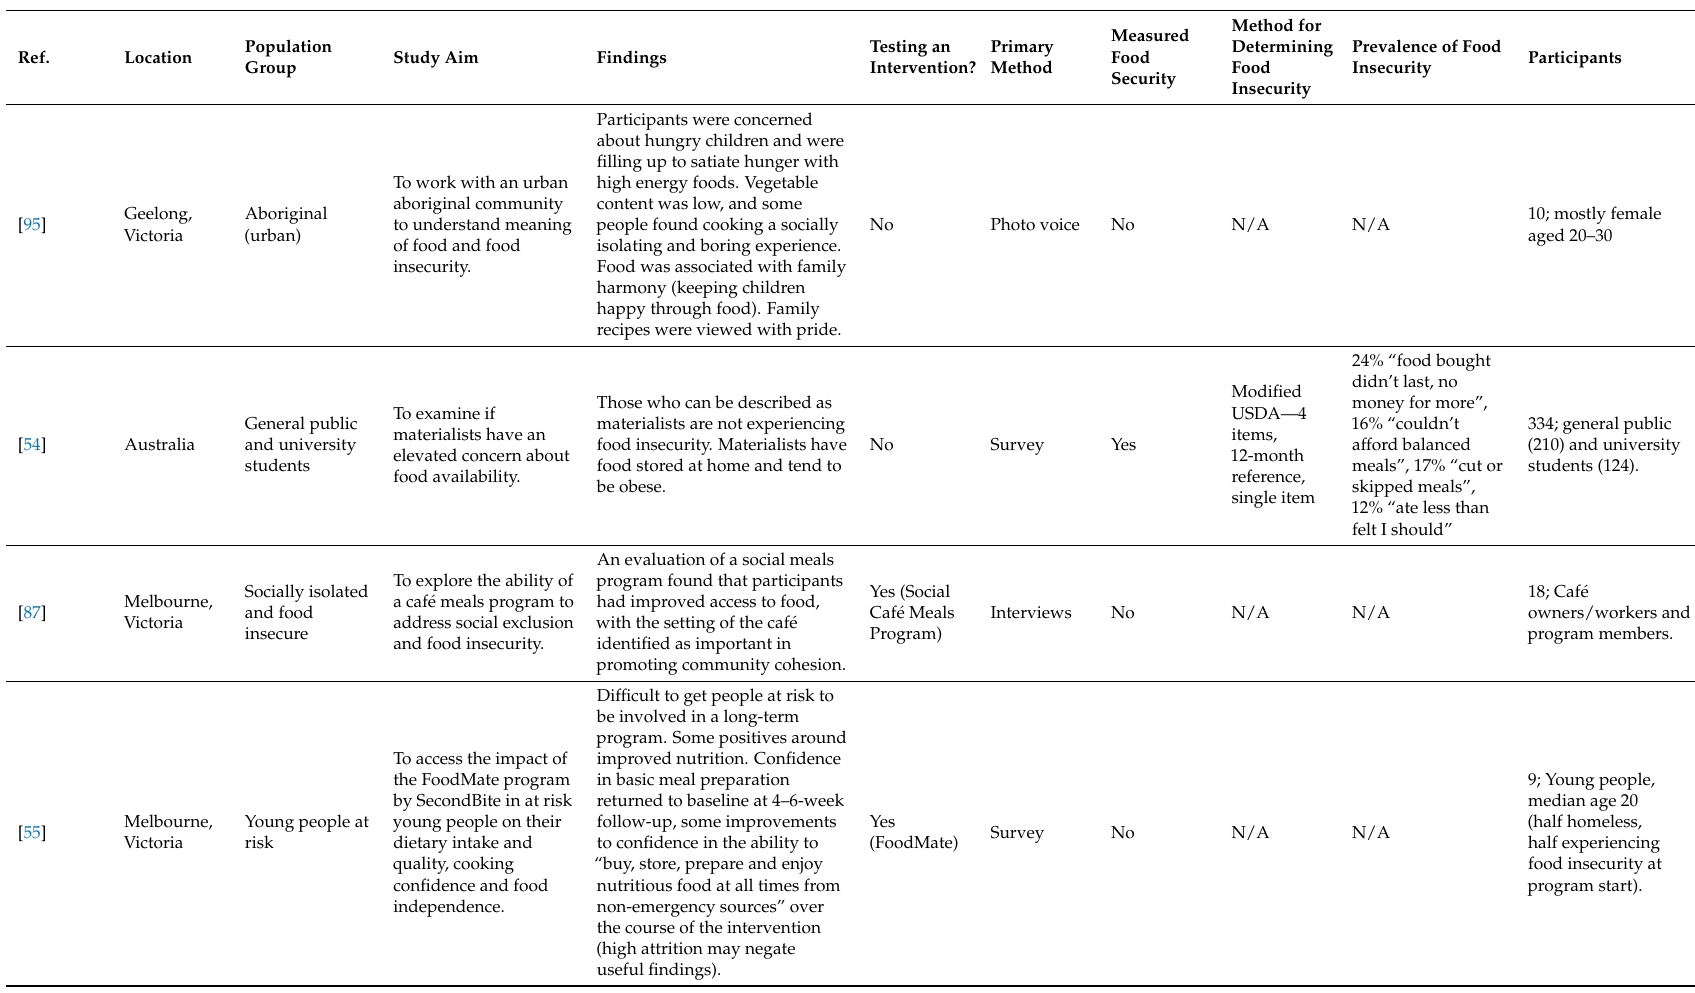
Table 1. Summary of 57 studies included in systematic